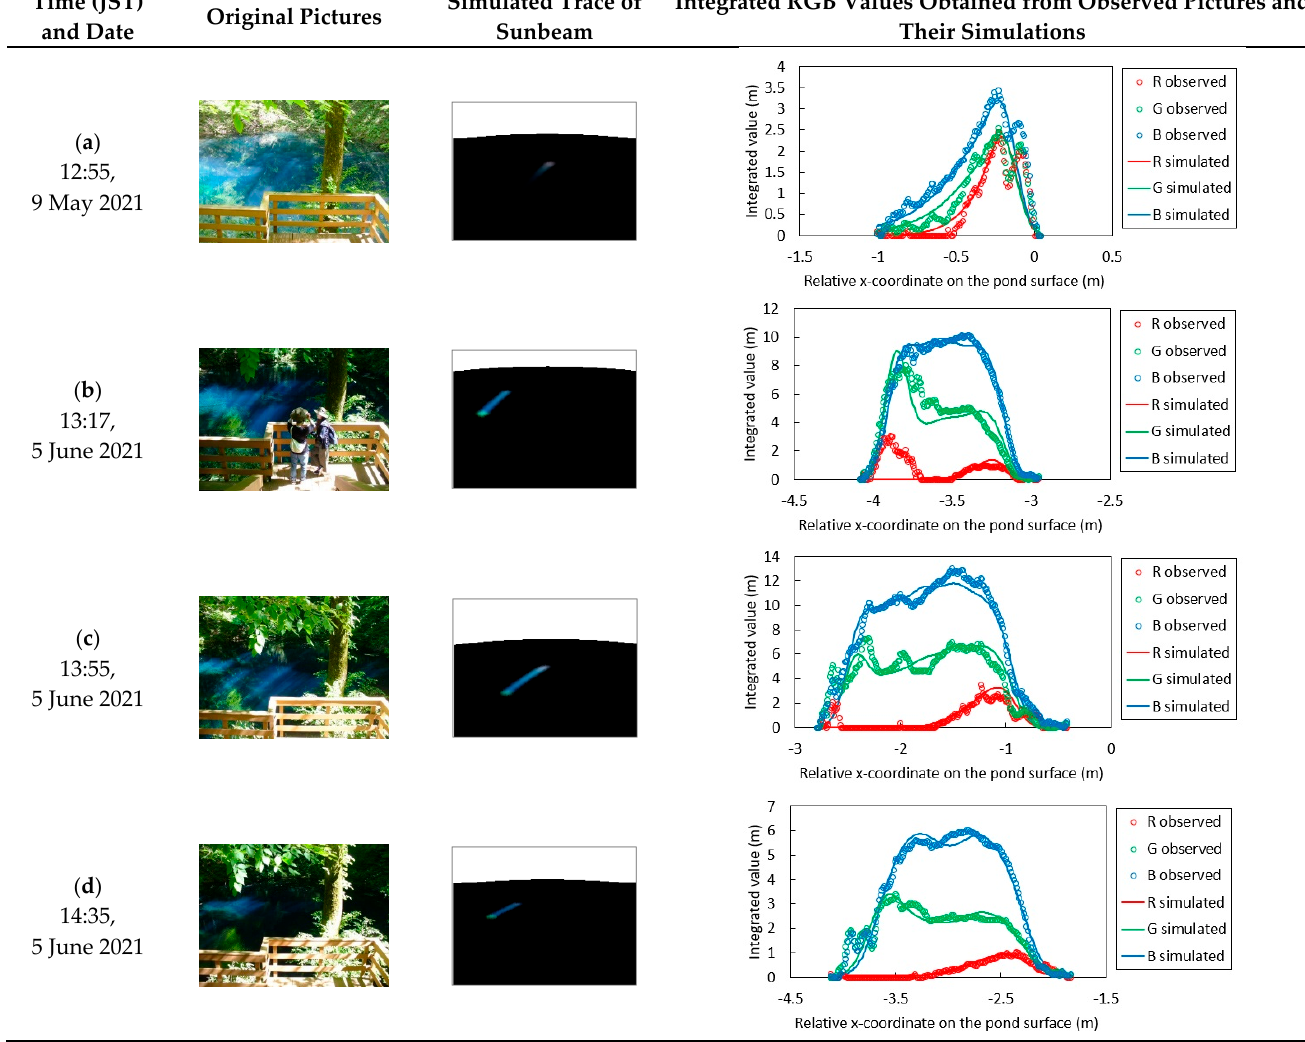
Figure 19. Original images on ( a ) 9 May and ( b – d ) 5 June 2021, their simulations and integrated RGB values analyzed on sunbeams, which depict the situations for fitting. Table 3. Given and settled parameters applied in the image analyses. ( a – d ) correspond to the numbers in Figure 19. Common values of the parameters are listed below the table. Symbol Meaning and Unit ( a )